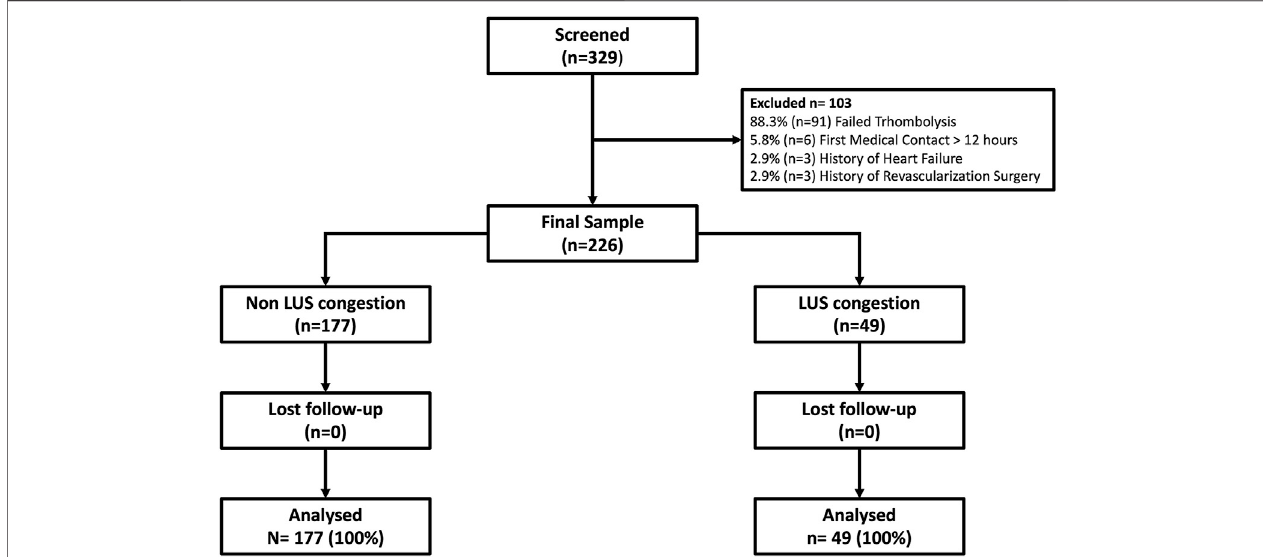
FIGURE 2 | Flowchart of the sampling process.